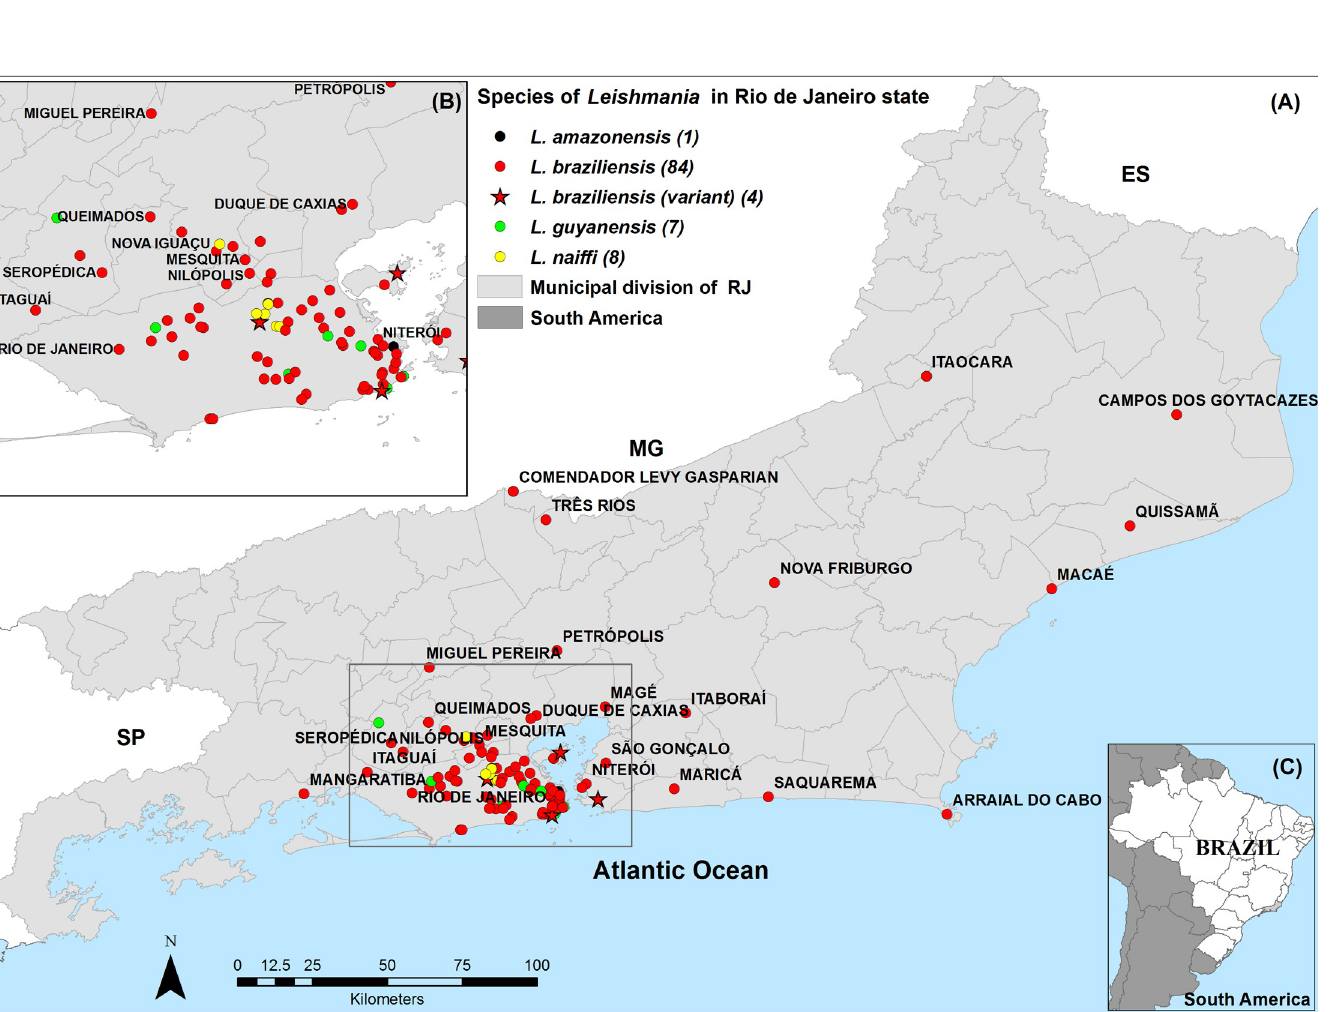
PLOS NeglectedTropical Diseases | https://doi.org/10.1371/journal.pntd.0007748 November15,